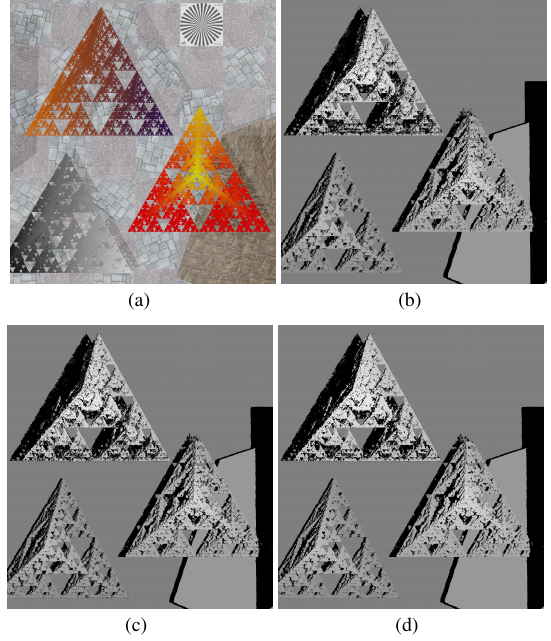
Figure 8. SGM on the detailed scene subset (a) RGB image, (b) height image for 8 directions, (c) 8 directions offset by 11 ◦ , (d) 256 directions